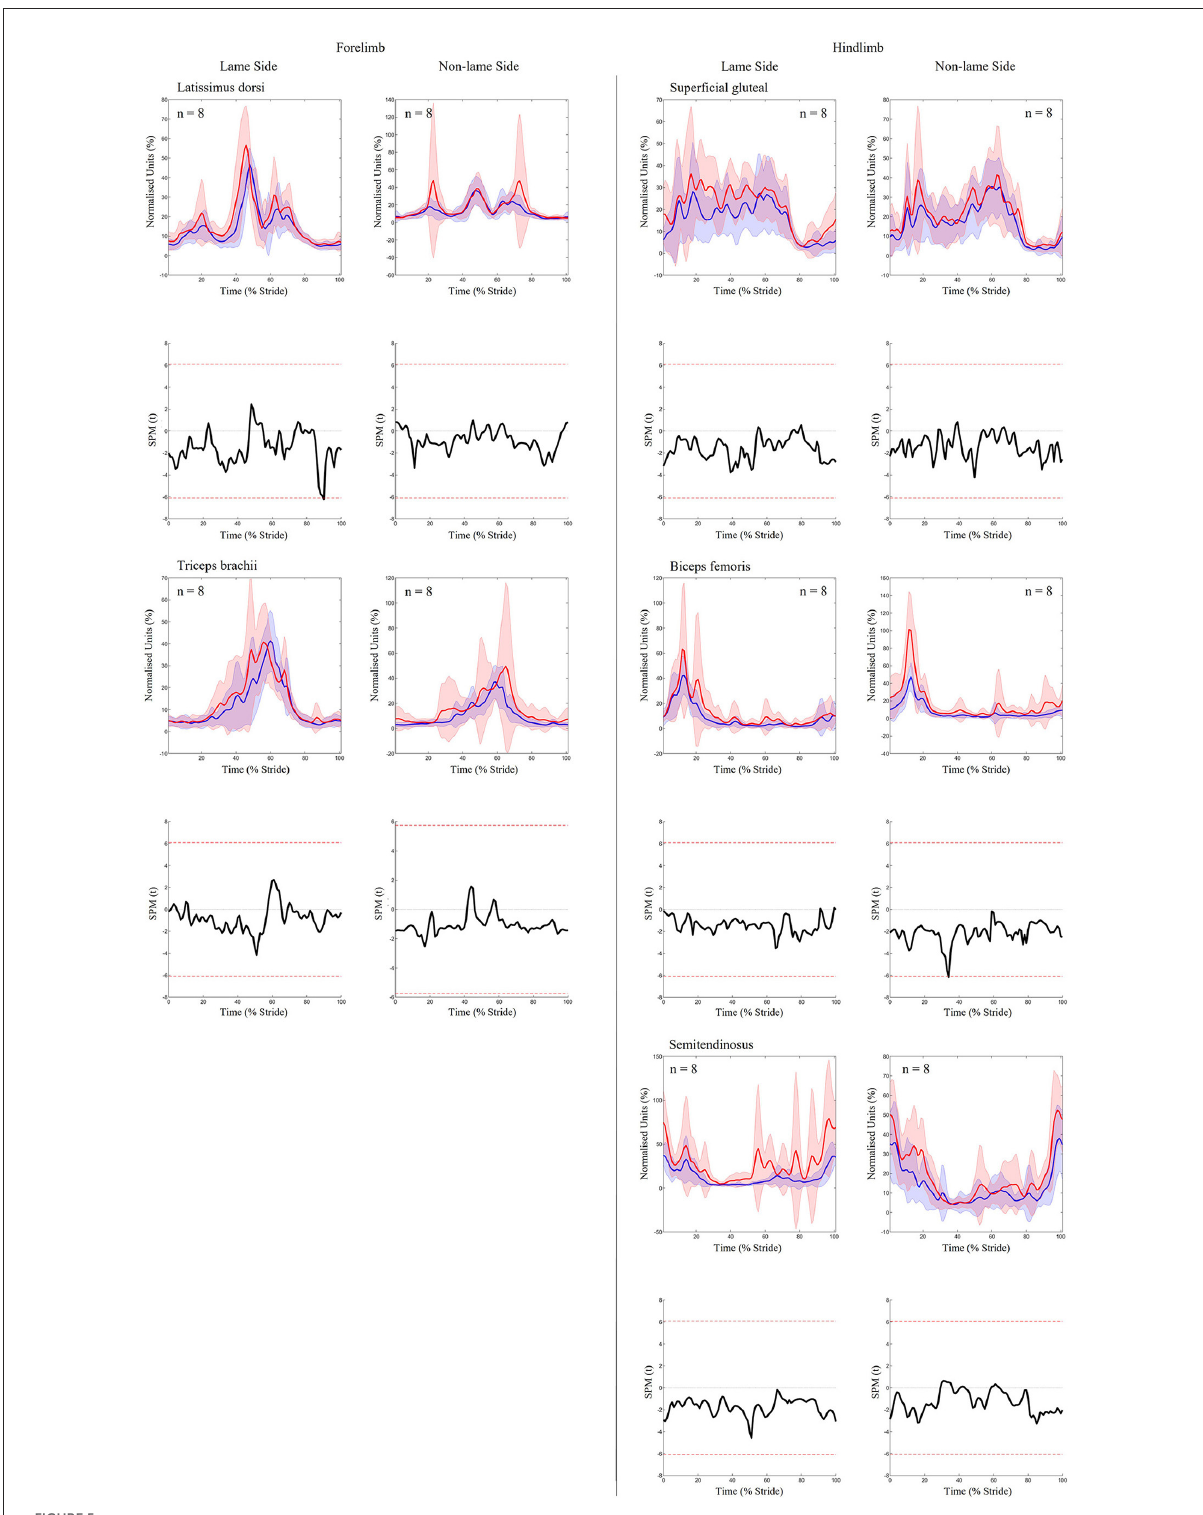
FIGURE5 SPM results for time- and amplitude-normalized sEMG data across the group of horses ( n = 8) for studied superficial muscles of the forelimb (Left panel) and hindlimb (Right panel) during baseline 1 (blue solid lines/shaded area) and induced hindlimb lameness (red solid